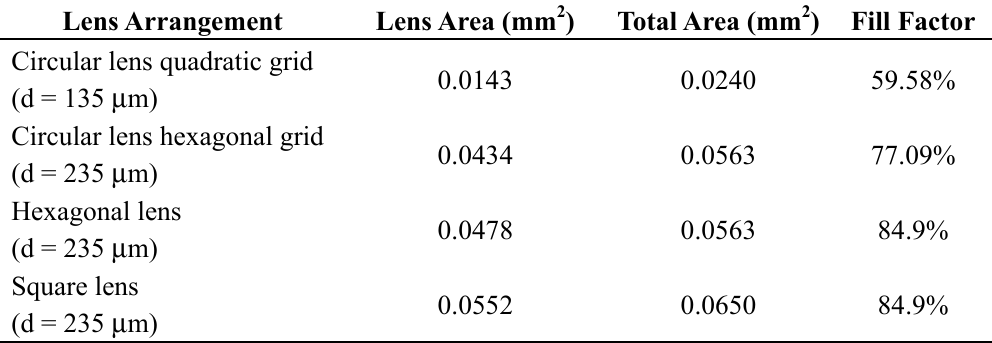
Table 1. Lens arrangement versus fill factor for 20 μ m of lens gap.